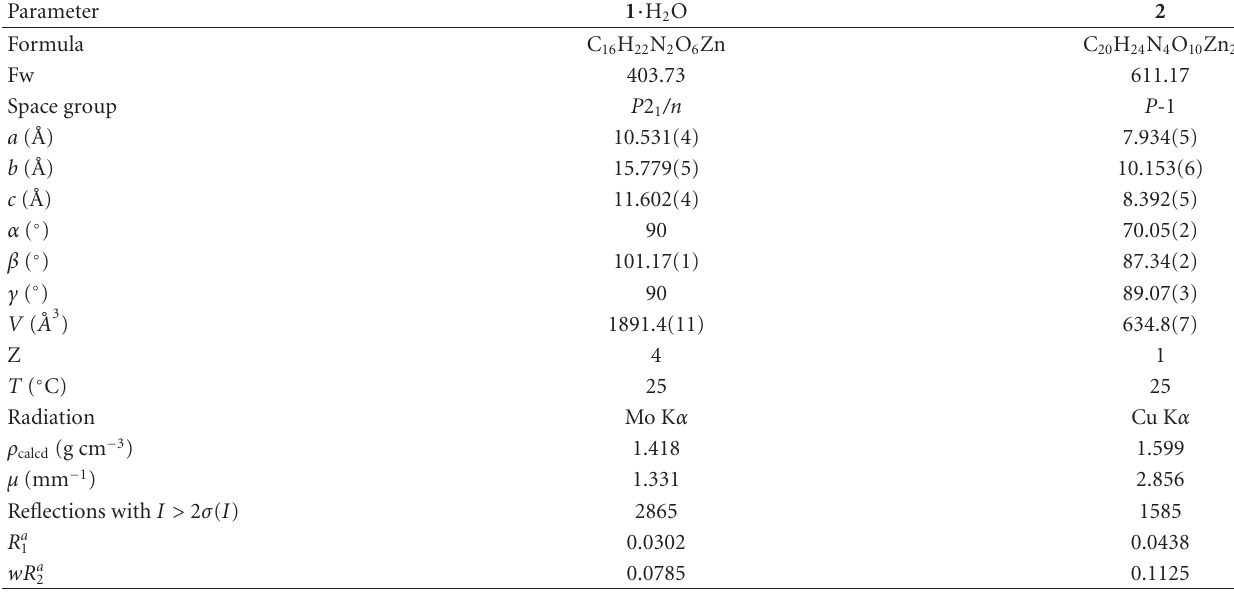
Table 1: Crystallographic data for complexes 1 · H 2 O and 2